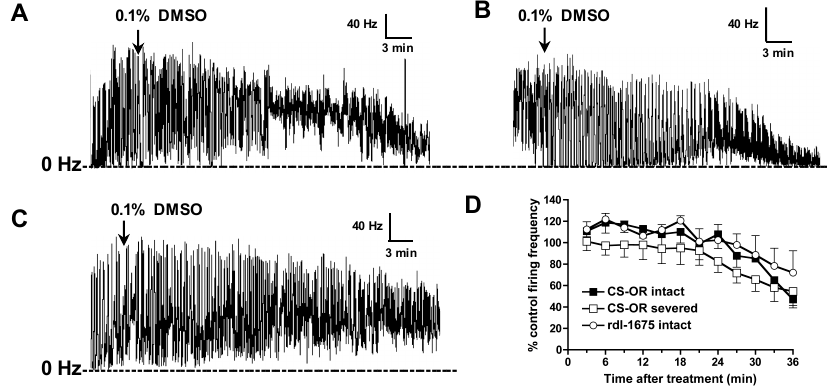
Figure 4. DMSO effects on D. melanogaster larval CNS. Ordinate in all traces is spike rate in Hz (spikes/s) vs. time (abscissa). ( A ) Recording of intact CS-OR larval CNS treated with DMSO; ( B ) Recording of severed CS-OR larval CNS treated with DMSO; ( C ) Recording of intact rdl -1675 larval CNS treated with DMSO; ( D ) Summary plot of DMSO effects on D. melanogaster larval CNS. Each data point was averaged over at least three replicates and error bars represent ± SEM. Dashed line in A – C is the zero Hz baseline in this and subsequent figures displaying nerve firing